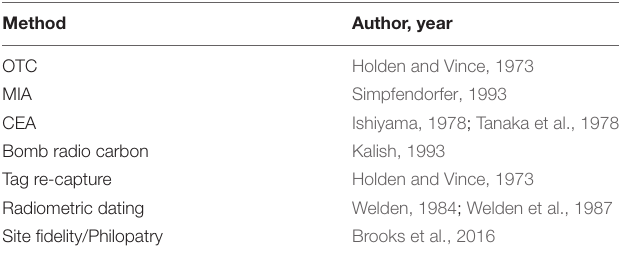
TABLE 2 | Examples of methods used for validation and verification is ageing